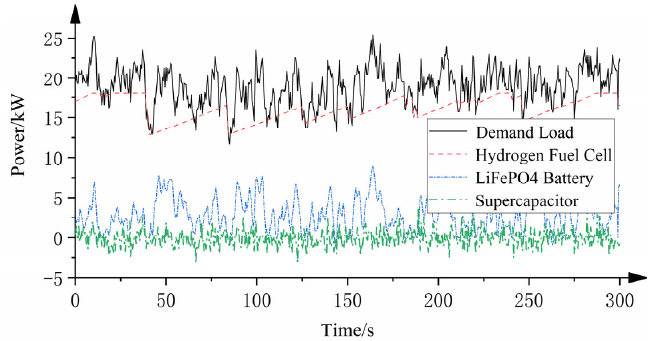
Figure 13. The power output of each energy part.